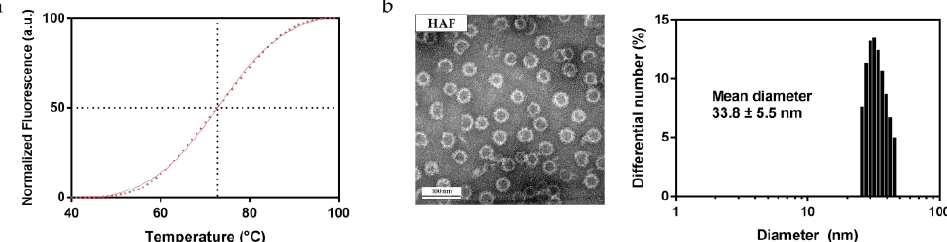
Figure 2. Thermostability of HAF. ( a ) Melting temperature analysis of HAF. The thiol-reactive probe was used for plotting the melting temperature curve of HAF. The calculated melting temperature of HAF was 72.80 °C. ( b ) TEM and DLS analysis of HAF after 7 days incubated at 42 °C. The results from the TEM and DLS suggest that HAF can maintain a capsid structure for at least 7 days at 42 °C.